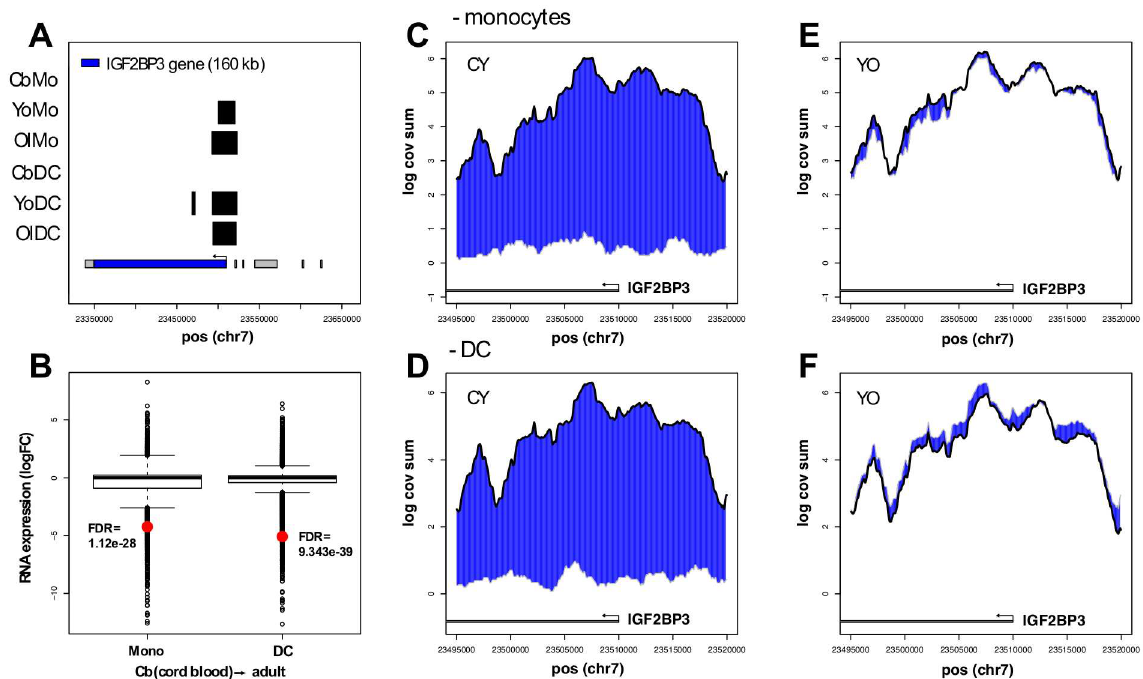
Fig 7. IGF2BP3-associated PcG region: Newborn vs. adult profiles. A. Estimated region boundaries for a relatively large (approx. 27 kb) H3K27me3-enriched domain overlapping the IGF2BP3 promoter region in adult samples. B. Postnatal down-regulation of IGF2BP3 monocyte and DC expression (log fold change). Panels CDEF represent coverage profile comparisons for this region (2 kb resolution, 50 bp steps), with differences highlighted in blue. CY, cord blood-young; YO, young adult-old adult. The gray and black lines that form the boundaries of the highlighted blue region denote cord blood (panels CD) or young (panels EF), and young (panels CD) or old (panels EF), respectively. The gray bars with arrows at bottom indicate the transcribed IGF2BP3 region that falls within the plotted region.